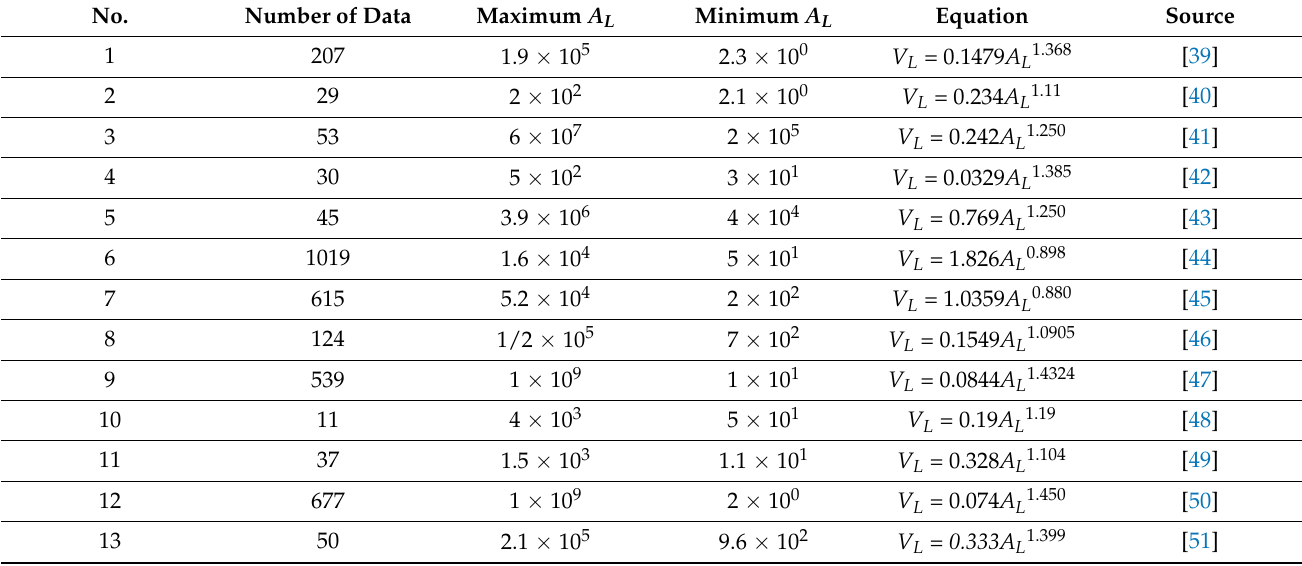
Table 4. Empirical relationships linking the landslide area ( A L ) to the landslide volume ( V L ) obtained by various researchers. No. Number of Data Maximum A L Minimum A L Equation